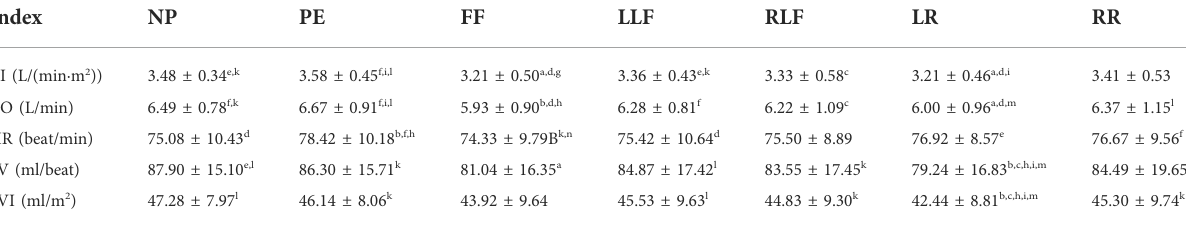
TABLE 2 Effects of different sitting postures on cardiac output and heart rate ( n = 12).